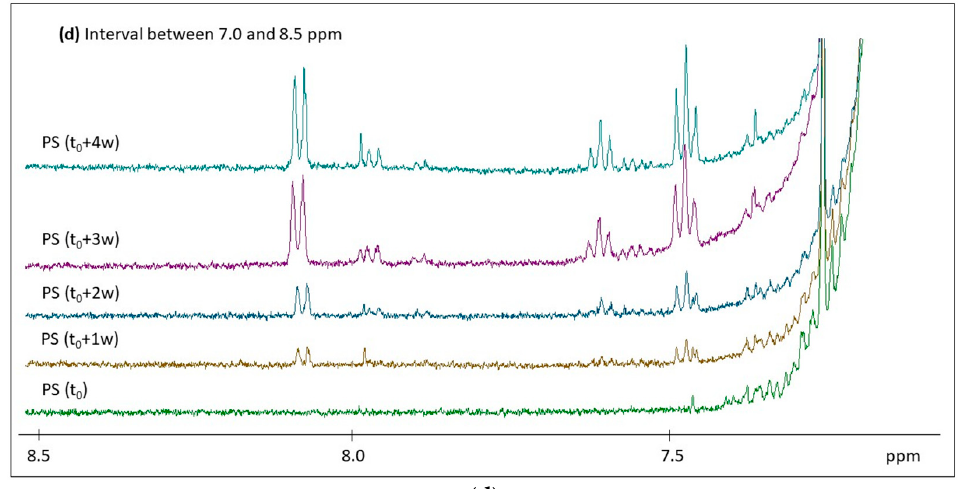
Figure 3. 1 H NMR spectra of PS microplastics during degradation. ( a ) 1 H NMR spectrum of the pristine PS microplastics. Stackplot of the 1 H NMR spectra of the PS microplastics at different times of irradiation (from bottom to top): t 0 , t 0 + 1 w, t 0 + 2 w, t 0 + 3 w, and t 0 + 4 w, in the spectral regions between 2.1 and 3.6 ppm ( b ), between 3.5 and 5 ppm ( c ), and between 7.0 and 8.5 ppm ( d ). Spectra were normalized with respect to the aromatic signal centered at 7.1 ppm. Stars signals are referred to solvent used for the 1 H NMR analysis.